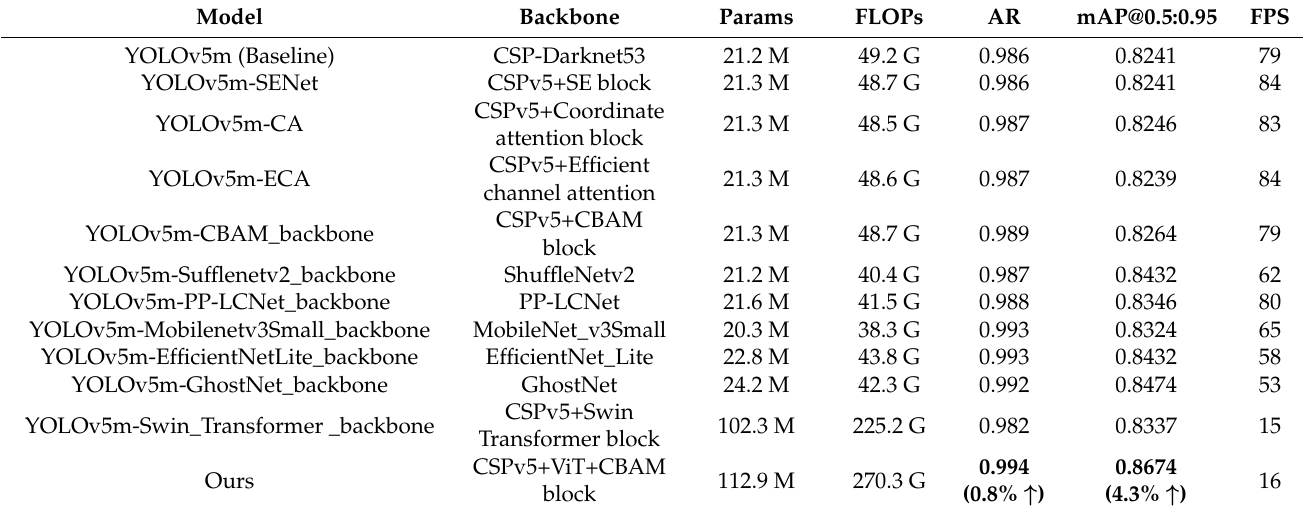
Table 3. Verification results under different backbone components (Stage